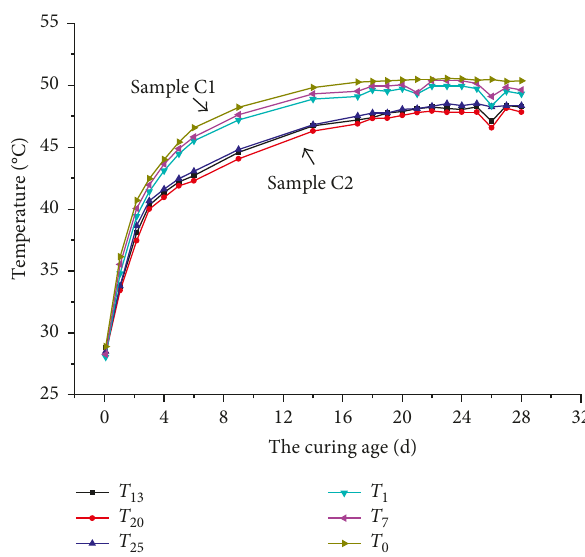
Figure 3: The temperature change of specimens at different sec- tions ( ° C). Table 3: The temperatures of specimens at different sections ( ° C). The sensor The curing ages